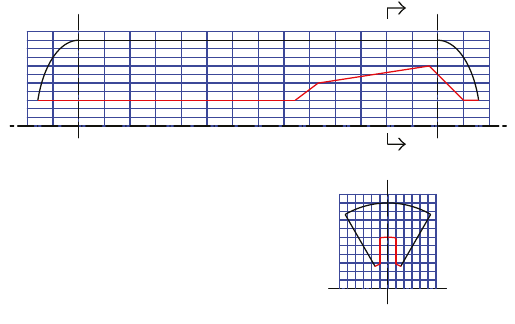
Figure 1: Computation